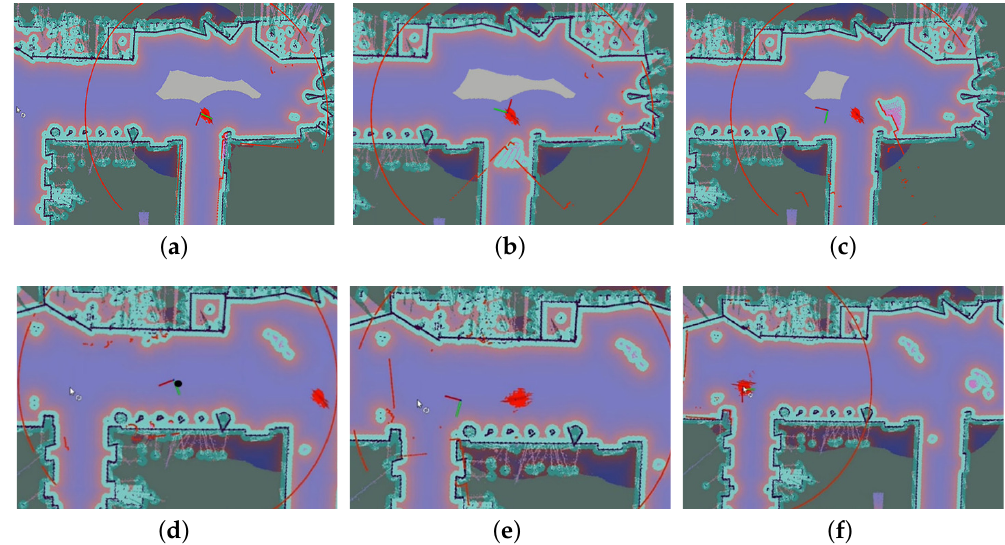
Figure 12. How UAPF achieves robot kidnap recovery. ( a ) Initial pose. ( b ) Rotating without odometry information. ( c ) Moving without odometry information. ( d ) First pose recovery. ( e ) The odometry is activated. ( f ) Second pose recovery is triggered, particles swarm is converged to true pose.